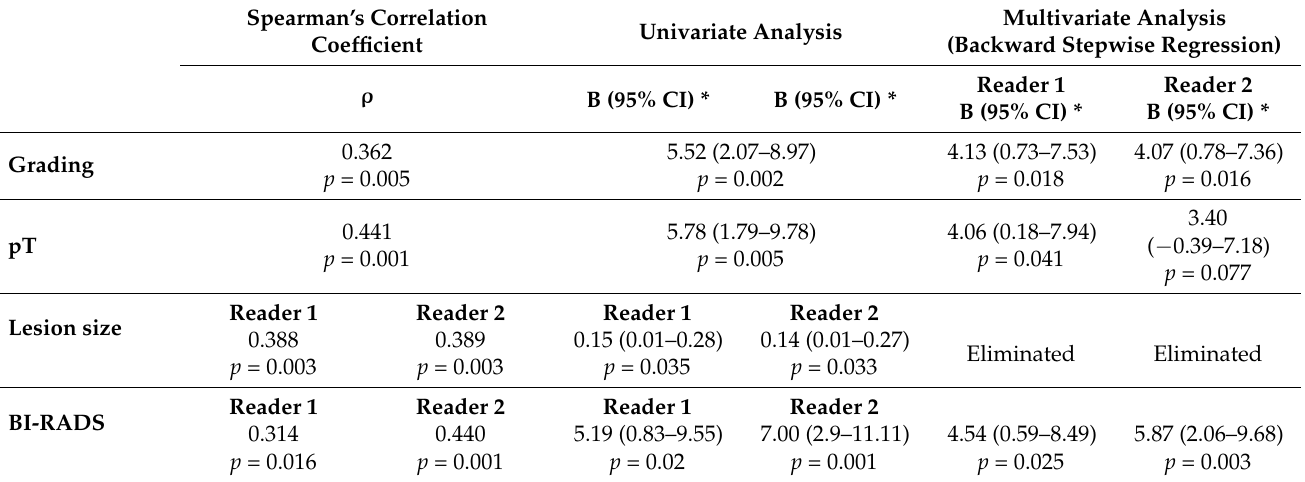
Table 2. Association between pathological and MRI-derived features of the lesions evaluated and ODXRS. The analysis was performed using Spearman’s correlation. Statistically significant results were further evaluated using univariate analysis. Variables that were significant in univariate analysis were included in multivariate analysis.